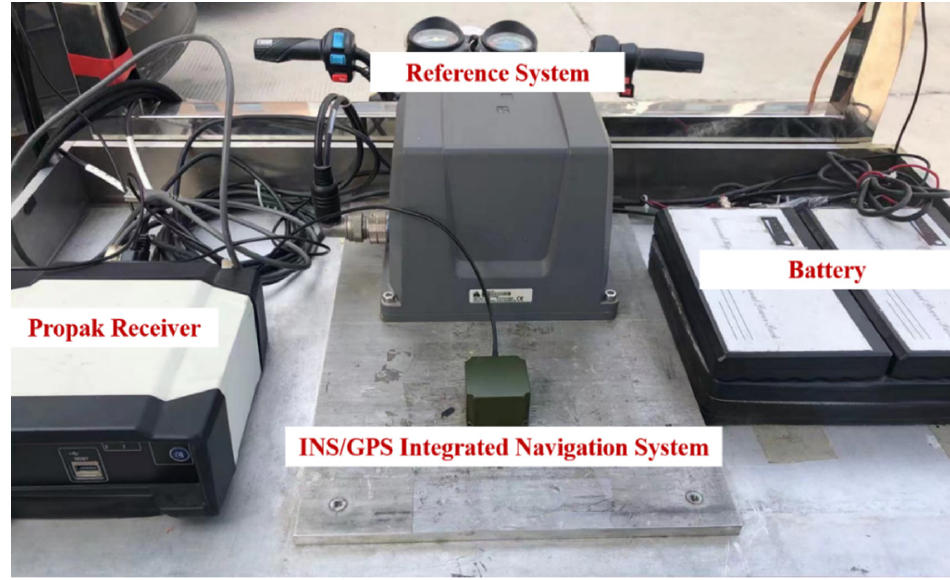
Figure 3. Vehicle navigation platform.